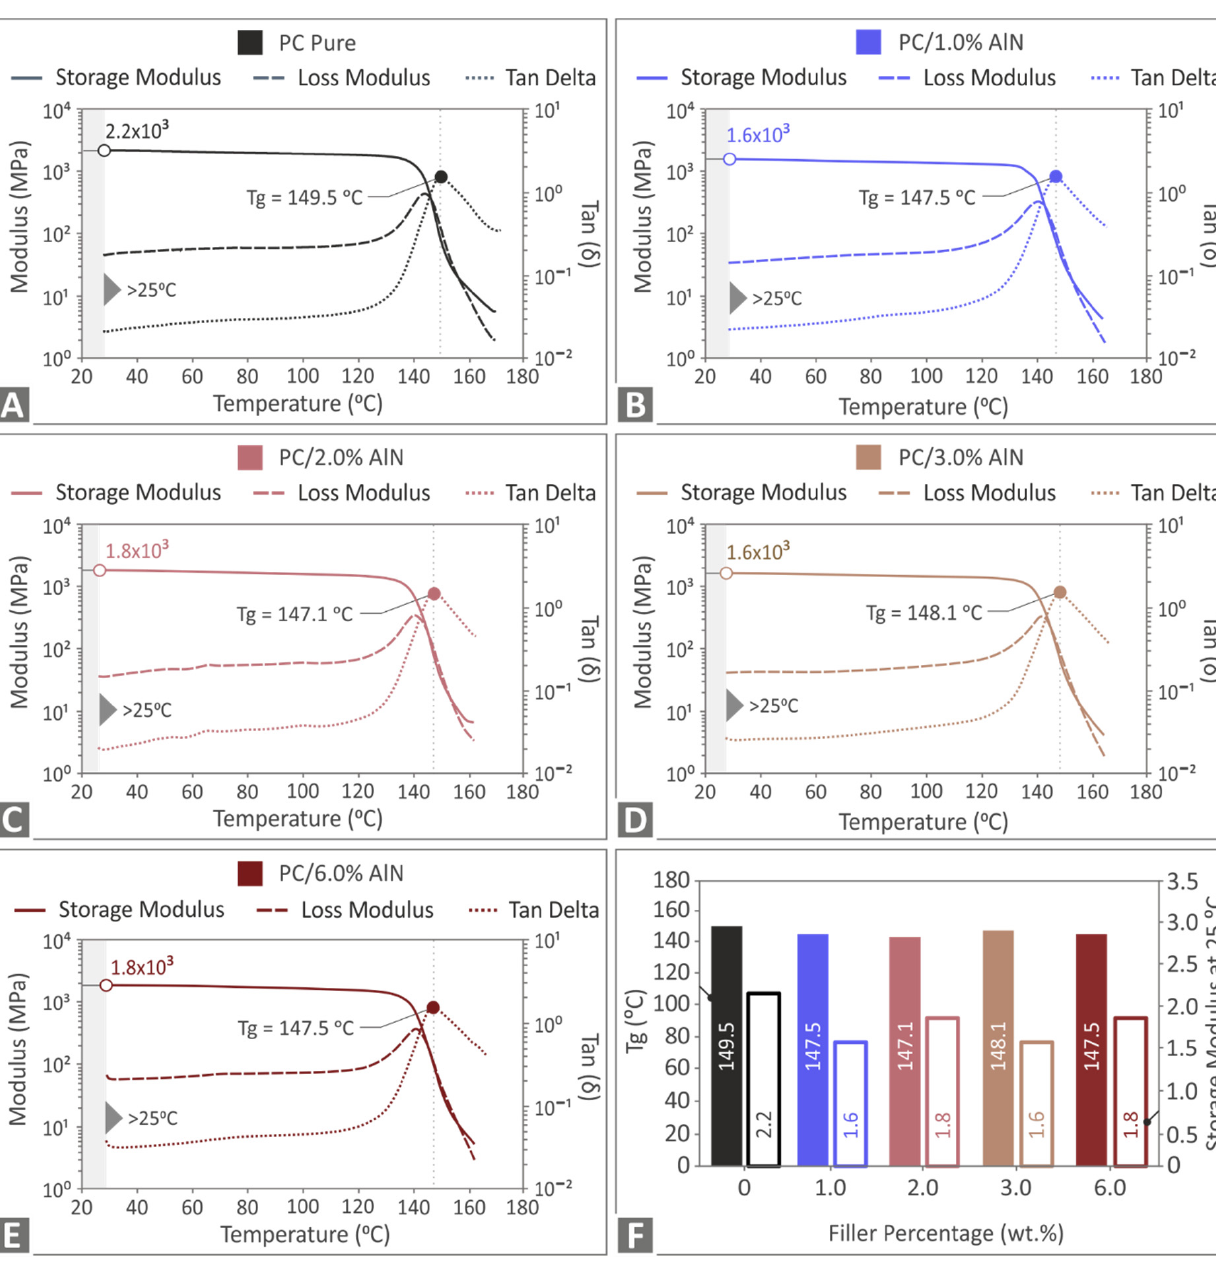
Figure 8. DMA results of storage and loss modulus, tan(delta)) for ( A ) pure PC, ( B ) PC/AlN 1 wt.%, ( C ) PC/AlN 2 wt.%, ( D ) PC/AlN 3 wt.%, ( E ) PC/AlN 6 wt.%, and ( F ) the calculated Tg (solid color bars) and storage modulus values (outline bars) at room temperature for all tested specimens.